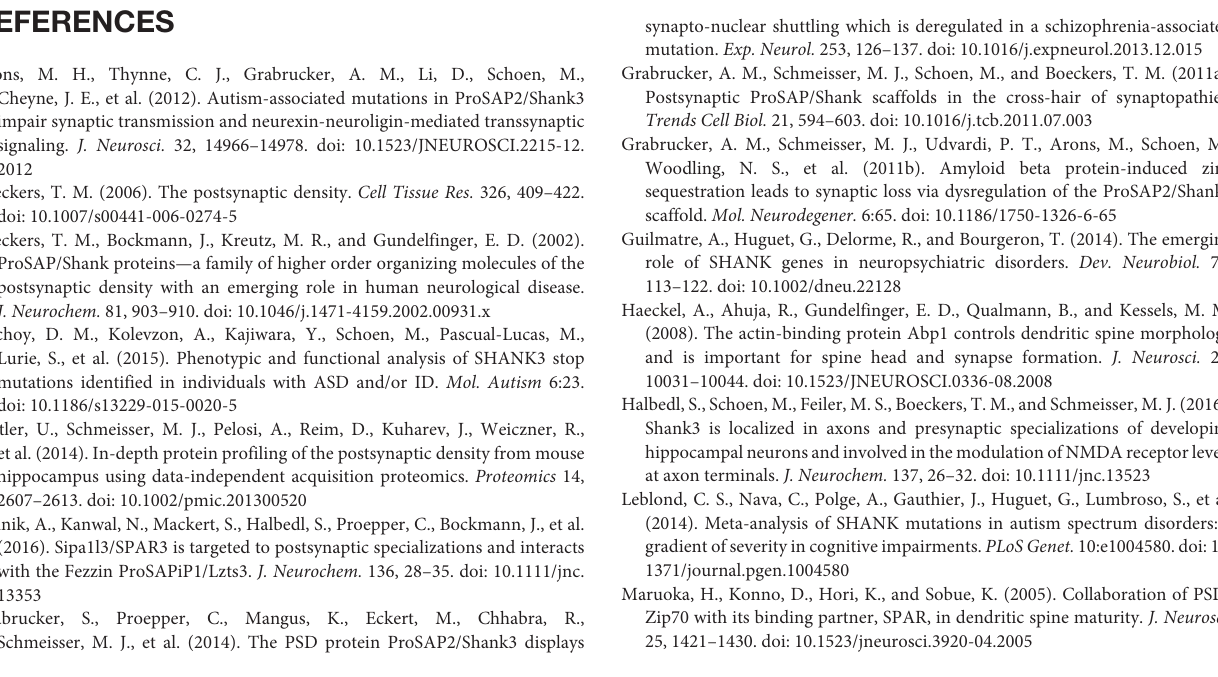
Supplementary Figure 1 | Characterization of a novel polyclonal anti-SPAR antibody. (A) Specificity testing of the anti-SPAR antibody. HEK293T cells were co-transfected with GFP-SPAR and either the control vector (Vector) or SPAR RNAi (for characterization of these constructs see Richter et al., 2007). Western blotting of the corresponding cell lysates with anti-SPAR (left panel) and anti-GFP (right panel) showed reduction of GFP-SPAR in the presence of SPAR RNAi. (B) HEK293T cells were further transfected with GFP-SPAR, GFP-SPAR2 or GFP-SPAR3. Western blotting of the corresponding cell lysates with anti-SPAR or anti-GFP showed that this antibody is not cross-reactive to SPAR2 and SPAR3.